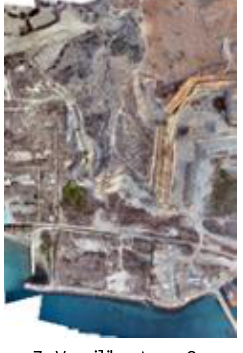
Figure 7: Vasiliko Area